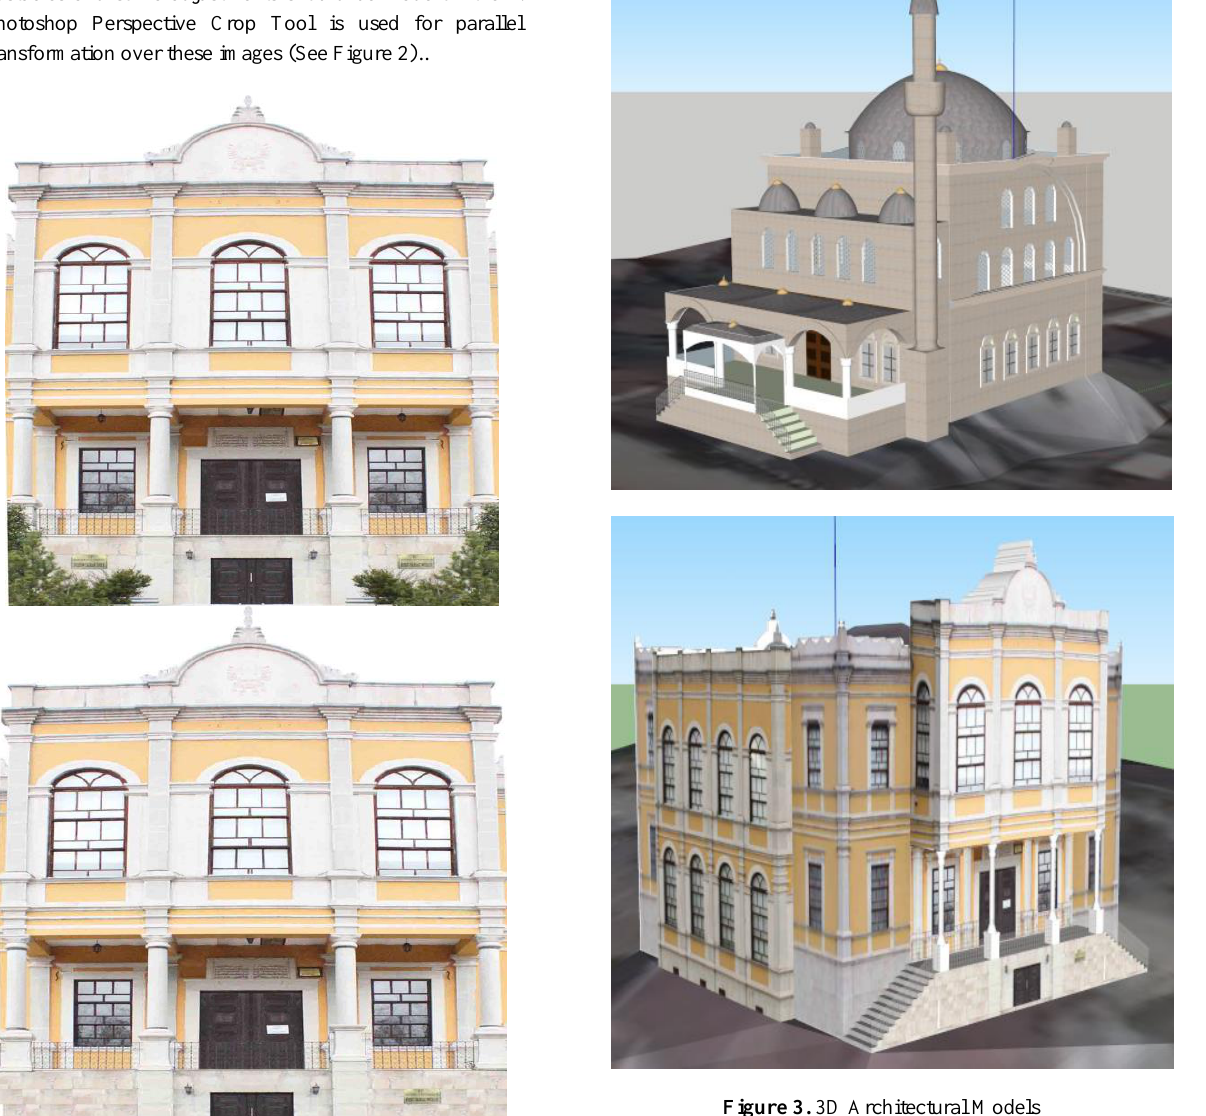
Figure 3. 3D Architectural